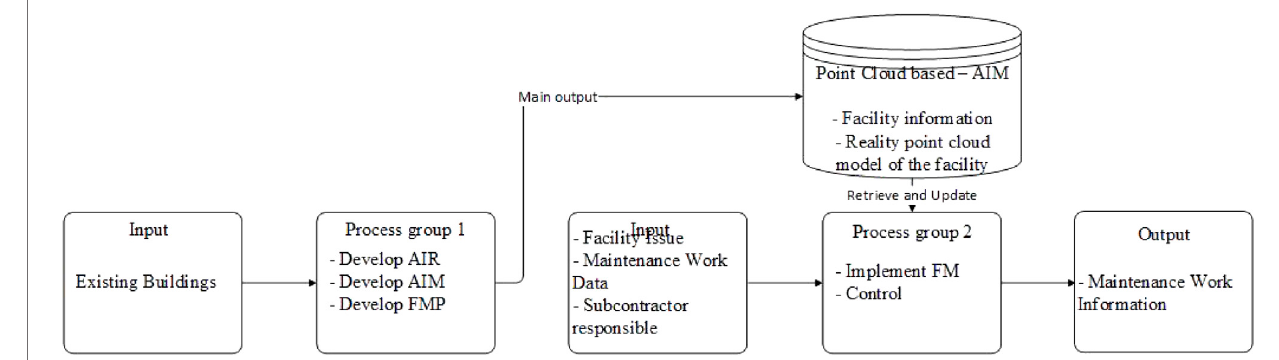
FIGURE 2 | Overall approach of the framework.